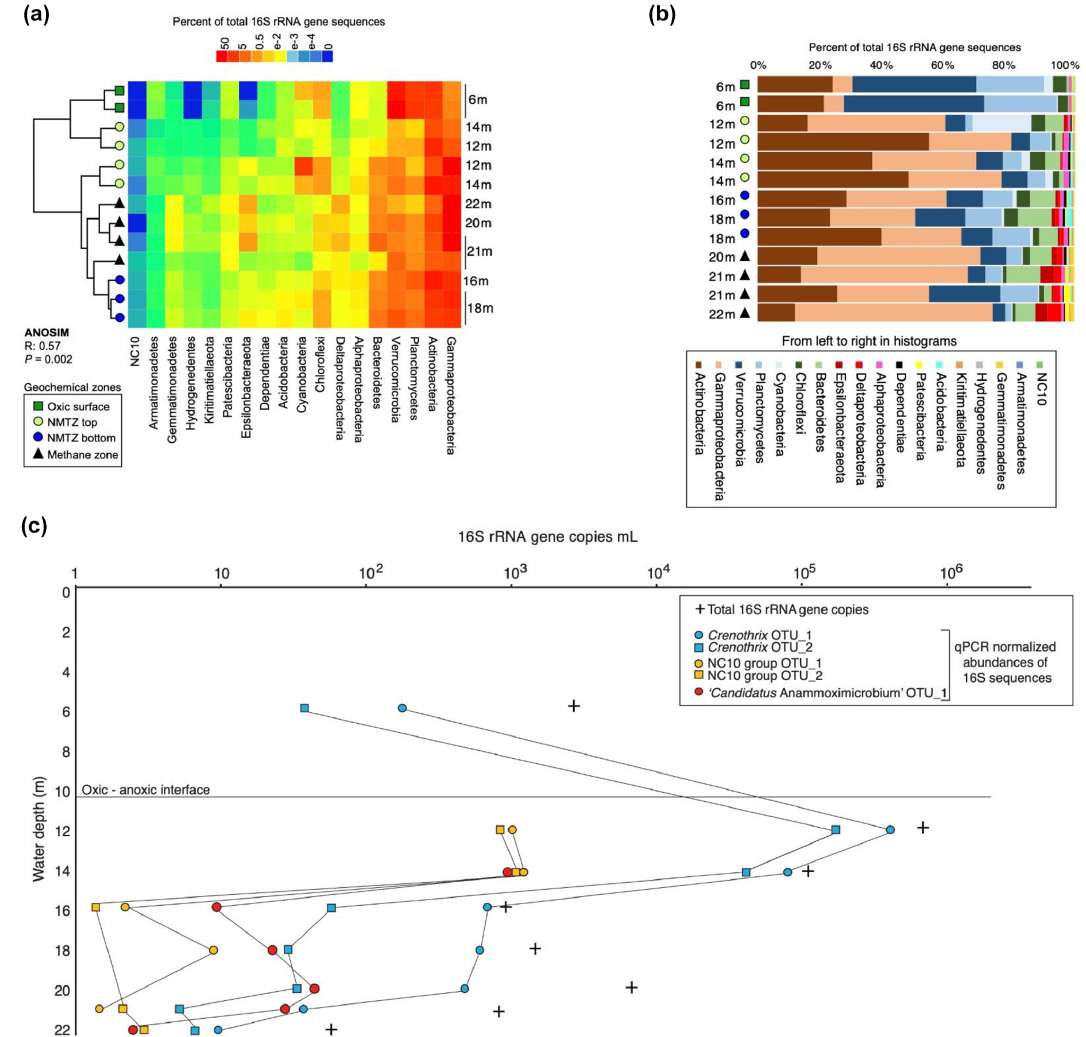
Figure 3. Analysis of 16S rRNA gene data from microbial communities in the stratified lake. (a) Heatmap showing the relative abundance of specific groups in the 16S rRNA gene sequencing data, and corresponding hierarchical clustering analysis (analysis of similarity (ANOSIM) P value = 0.002) of four geochemically defined zones. For depths where replicates were obtained, the data for both replicates are shown. (b) The relative abundance of 16S rRNA gene sequences affiliated with the major groups across the stratified water column. (c) Abundance of 16S rRNA gene copies determined via qPCR, and the qPCR normalized absolute abundances of 16S rRNA gene sequence relative abundances from key populations (OTUs) potentially involved in AOM and anammox, specifically those affiliated with Crenothrix , NC10, and potential anammox